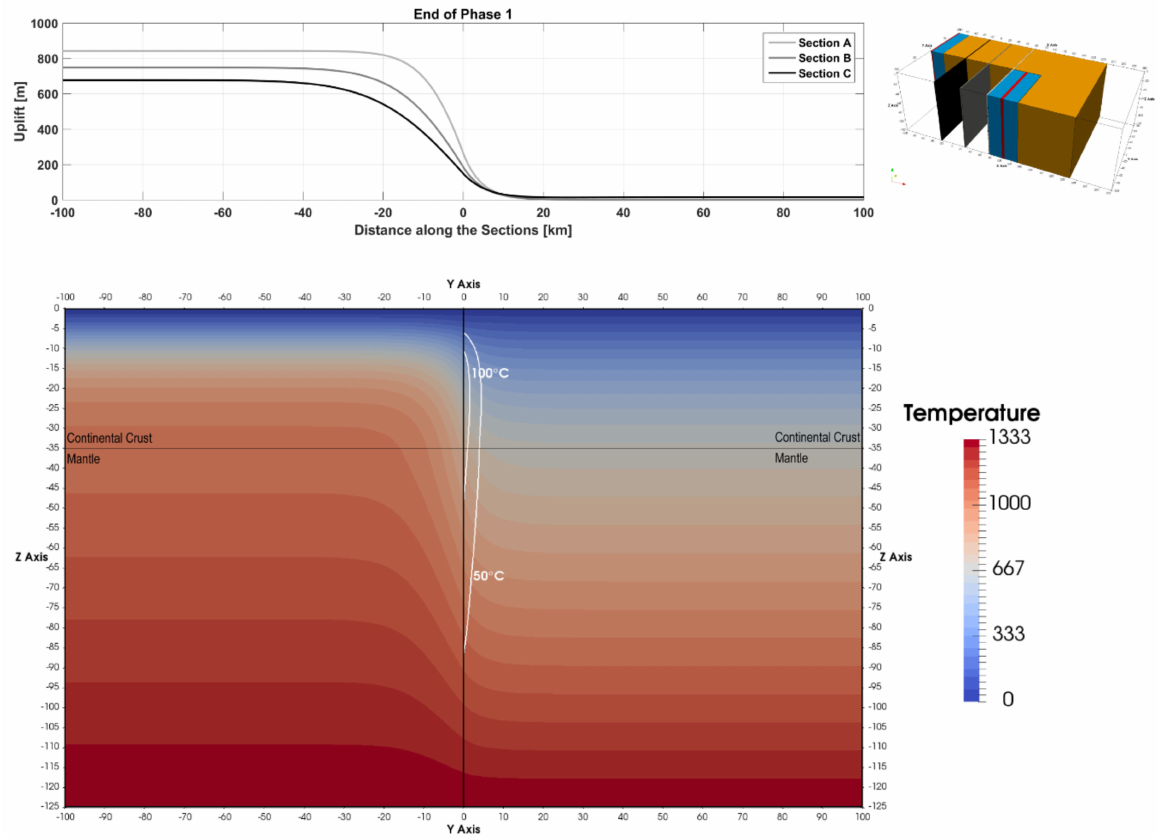
Figure 2. Thermal structure of the continental lithosphere along Section A at the end of Phase 1 (2.5 Myr). The thermal anomaly (white contour) extends 4.5 km laterally into the continental lithosphere across the transform margin. The vertical central line denotes the transform margin. The lithosphere to the left of the margin is continent adjacent to the leading ridge flank. The excess temperature contours are restricted to the northern side of the transform margin. The upper left panel shows the corresponding uplift calculated along all the sections at the end of Phase 1. Note that given their different initial positions, the time to reach the end of Phase 1 is different for the three sections. The upper right image shows the model configuration at the end of Phase 1 for Section